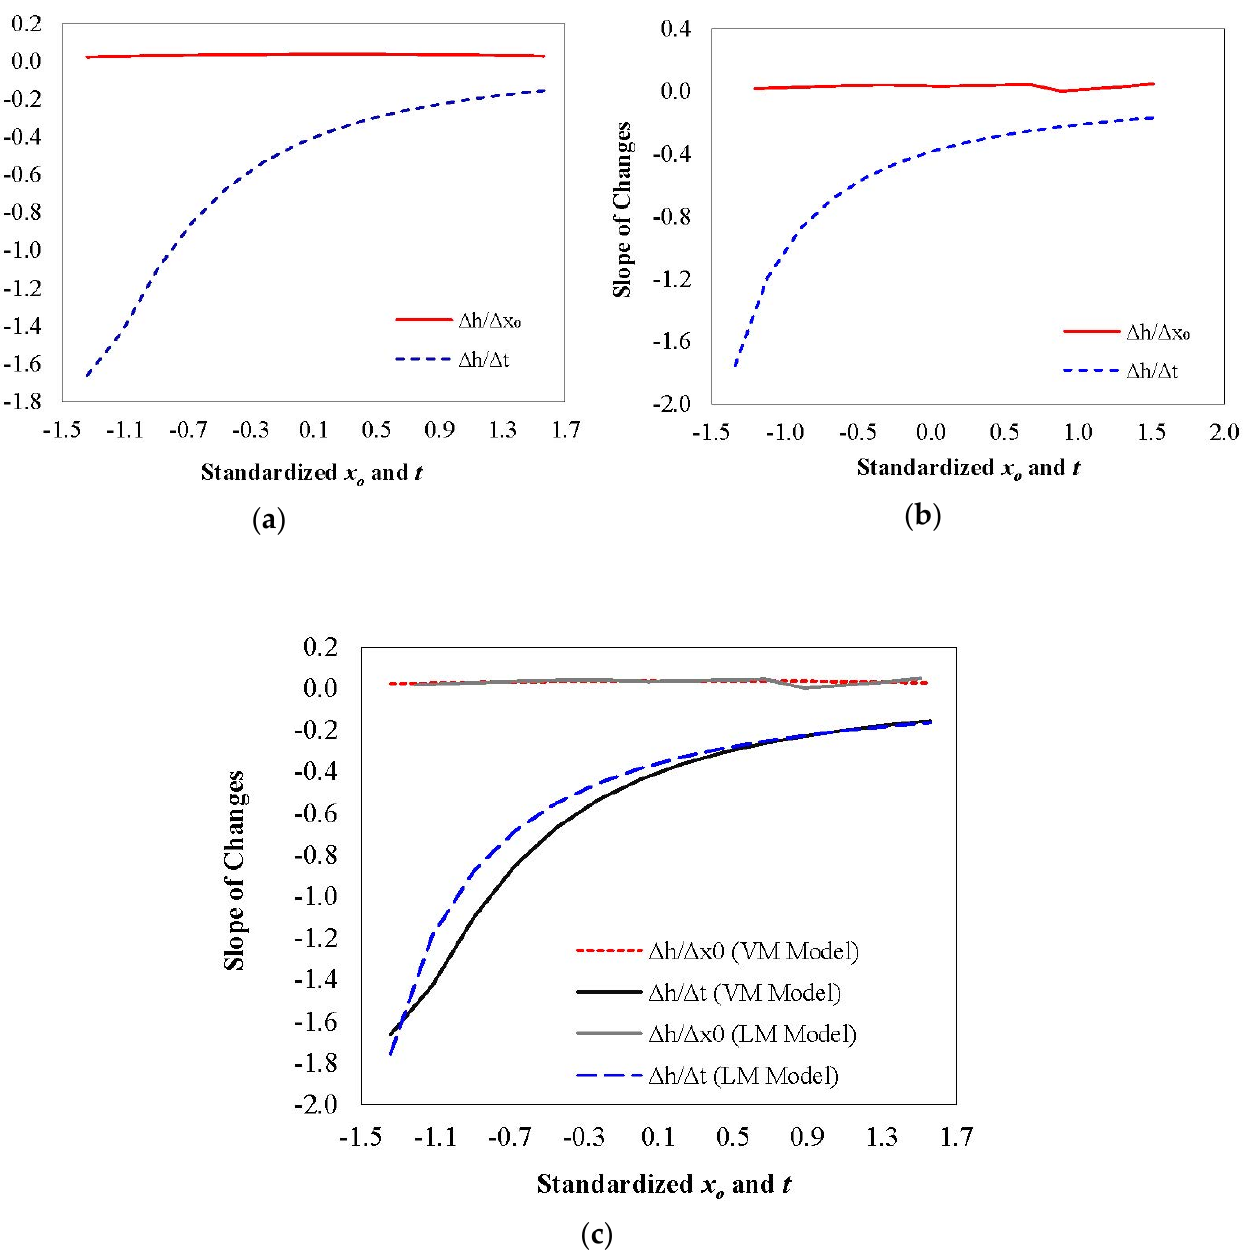
Figure 9. Slope changes in “interface height versus input parameter” as a function of the standardized input parameter predicted using ( a ) VL-based model and ( b ) LM-based model, and comparison of the two predictions in ( c ).